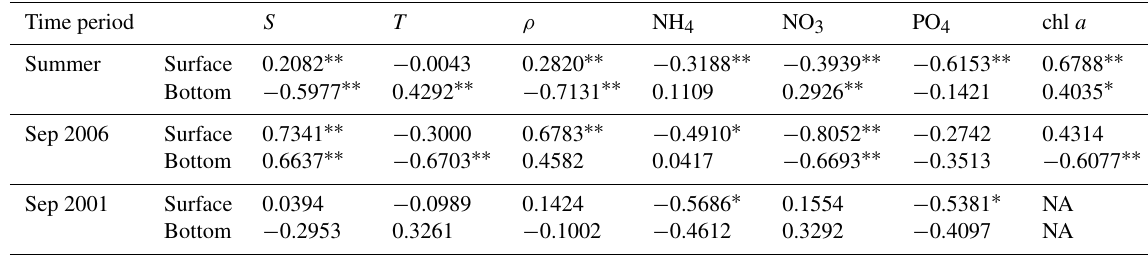
Table 2. Pearson correlation coefficients ( r ) between DO and other water quality metrics.